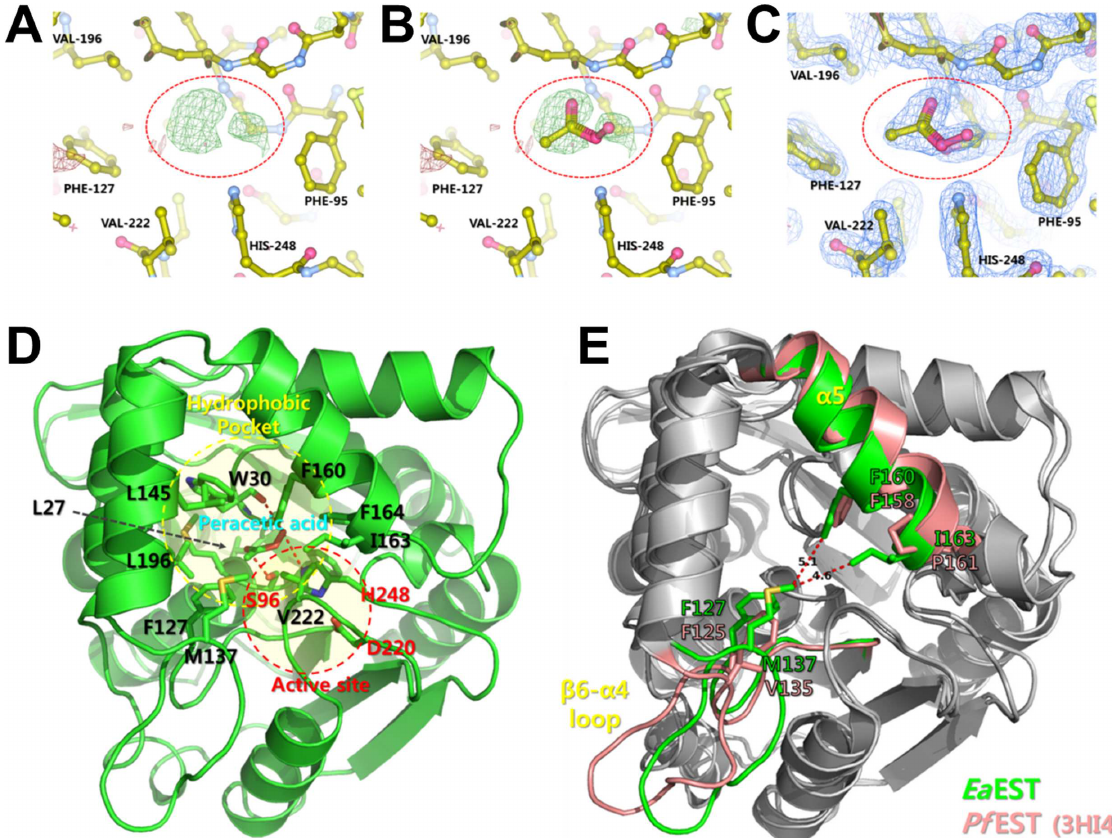
Fig 3. Peracetate-binding in Ea EST. (A) The positive electrondensity(green)was observedin the Fo-Fc omit map (contoured at 2.0 σ ). (B) The peracetatemodelwas overlaidon the Fo-Fc omit map (green,contouredat 2.0 σ ). (C) The 2Fo-Fc electron-density map at 1.0 σ is shownafter peracetatemodelbuildingand refinement. (D) Peracetate-bindingsite is shown.Side chainsof residues near ligandrecognizing hydrophobic pocket (yellowcircle) and active site (red circle) are indicated by sticks. (E) Conformational changesbetweenperacetate-bound Ea ESTand acetate-bound Pf EST (PDB code 3HI4). The β 6- α 4loop regionof Ea ESTmay undergo conformational changeto openthe entrancehydrophobic channelfor